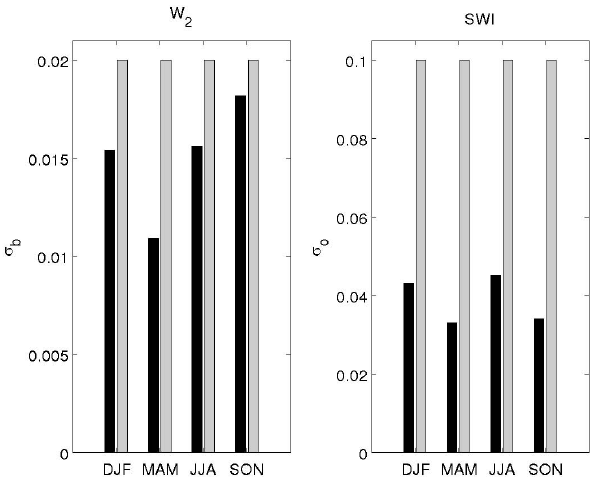
Fig. 10. Seasonal soil moisture diagnostics of background (left) and observation errors (right) used in this study calculated over the 7-year period at SMOSREX location. The estimated (diagnosed) values are in black, the specified values in gray.